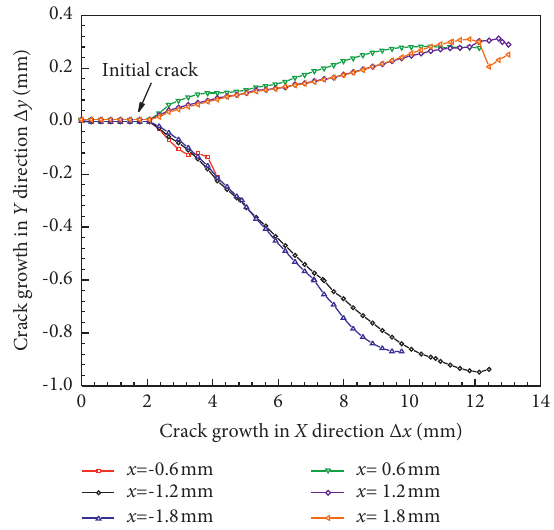
Figure 17: Crack extension paths of longitudinal